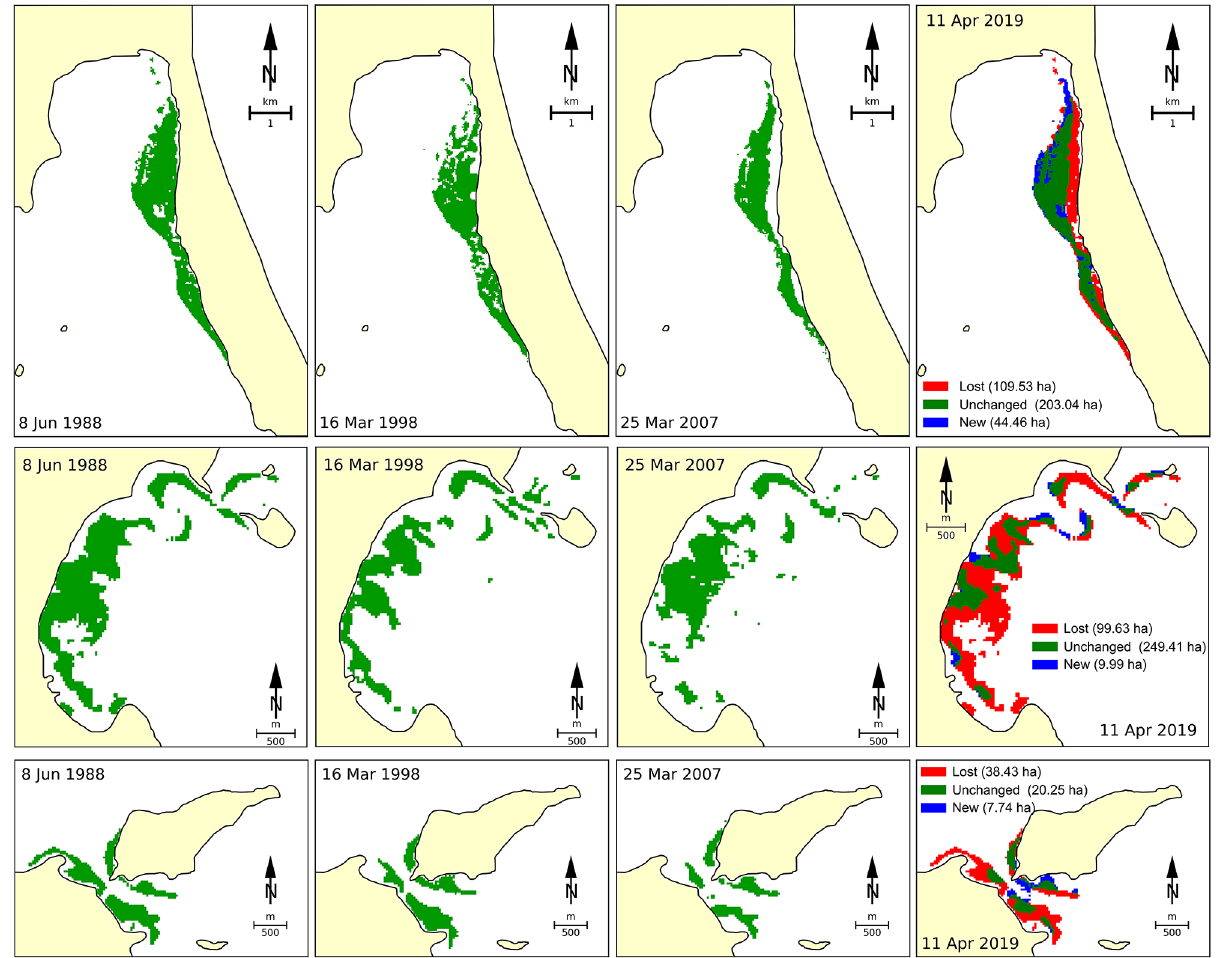
Fig. 7. Change detection of seagrass beds in 1988, 1998, 2007 at 2019 at VPB. Left to right, the fi rst, second and third rows present change detection of seagrass beds at TL, XT and MG respectively. In the satellite image classi fi cation, the unchanged seagrass beds are represented as green color in each speci fi c years, the new and lost seagrass beds are represented in blue and red colors. See Figure 1 for the abbreviation of locations.